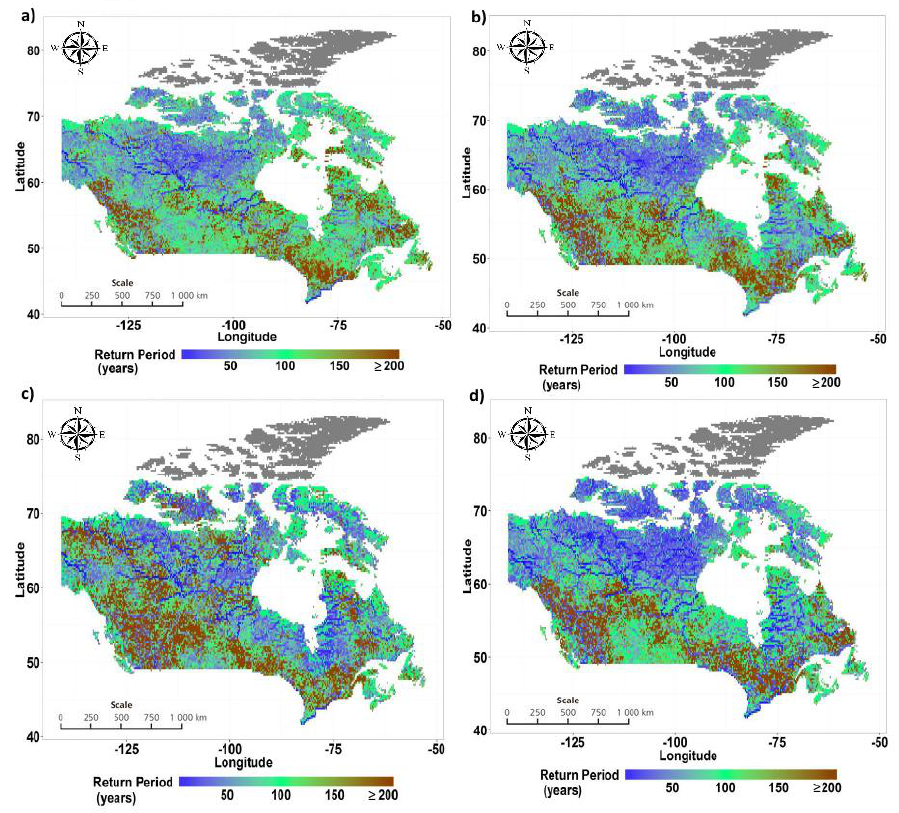
Figure 3. Future return periods of historical 100-year flood event for: ( a ) RCP 2.6; ( b ) RCP 4.5; ( c ) RCP 6.0; and ( d ) RCP 8.5. The results presented are GCM projections aggregated using the robust GCM median